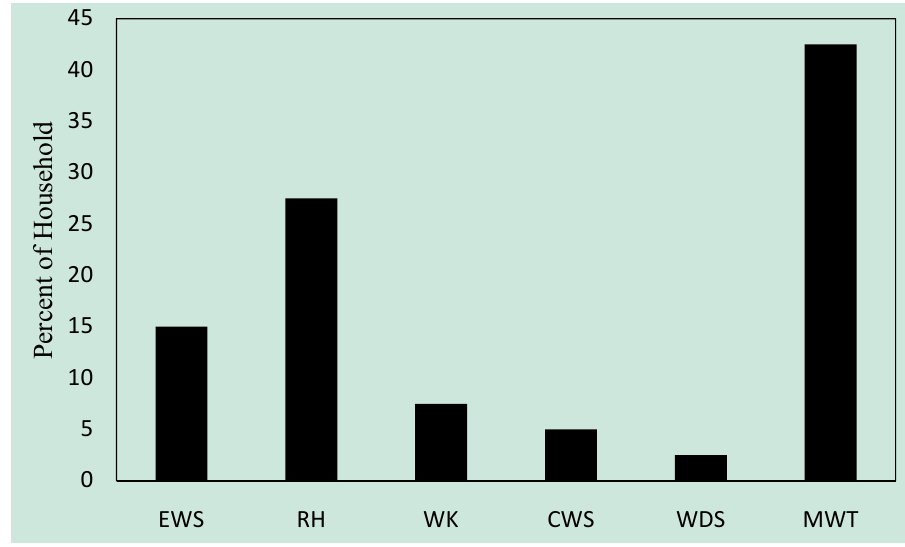
Figure 3. Community-Based Water Supply Systems Selected by Preference During the Surveys in the Yokoè